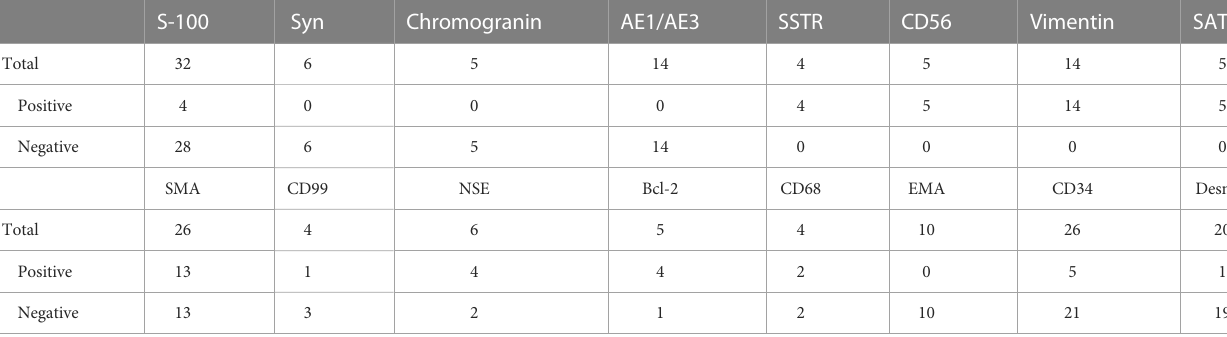
TABLE 5 Summary of the immunohistochemical results in the review including our